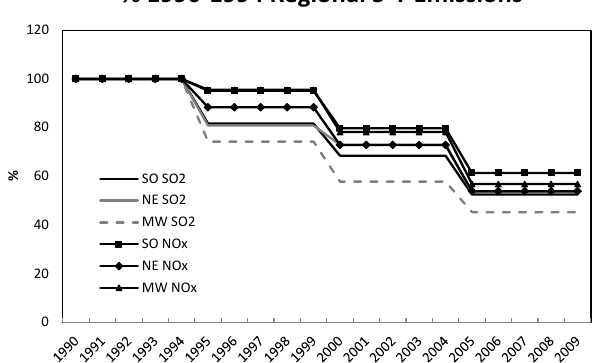
Figure 3. Estimates of regional mean annual SO 2 and NO x emis- sions for four 5-year periods (P1, P2, P3, and P4) between 1990 and 2009, expressed as percentages of the 1990–1994 (P1) regional means. In the SO, NE, and MW mean P1 SO 2 emissions are 3.48, 1.68, and 3.27TgSyr − 1 , and mean P1 NO x emissions are 1.89, 1.06, and 1.35TgNyr − 1 (Xing et al.,